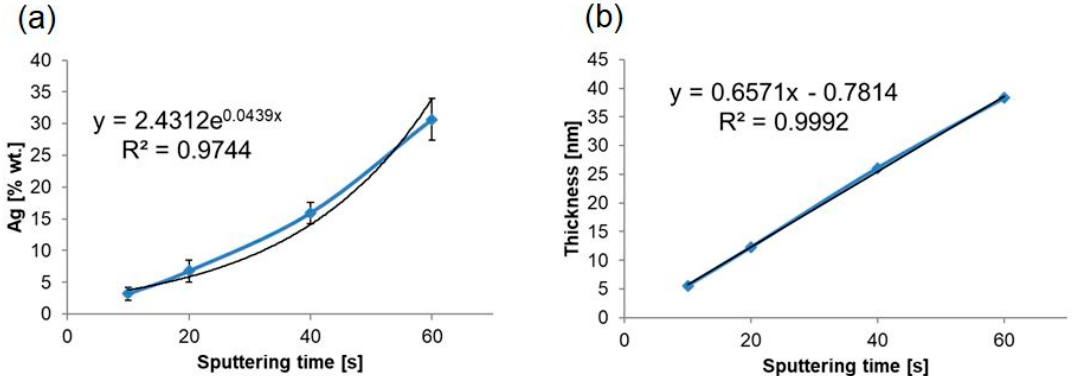
Figure 9. Chart presenting deposition duration dependency on the: ( a ) silver weight content and ( b ) thickness of silver layer in produced AgNPs/TNT platforms.